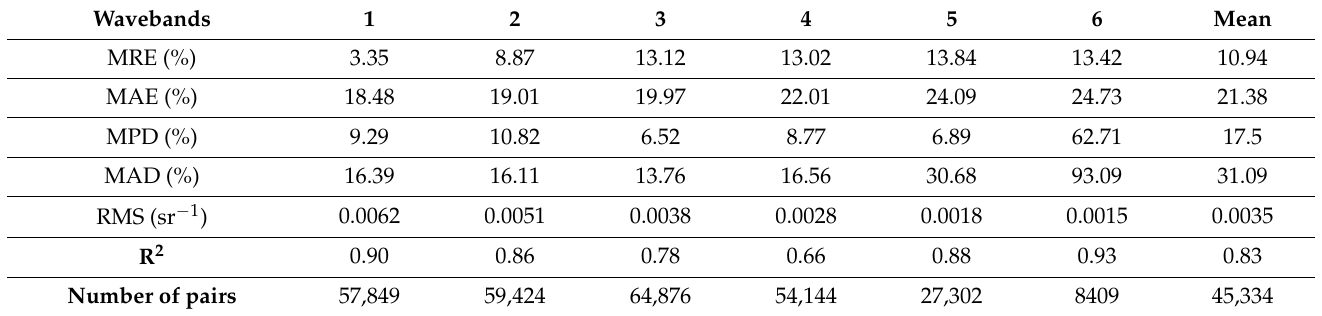
Table 4. The evaluation of the R rs of HY-1C on 2 October 2020, using those of Terra as the truth values.